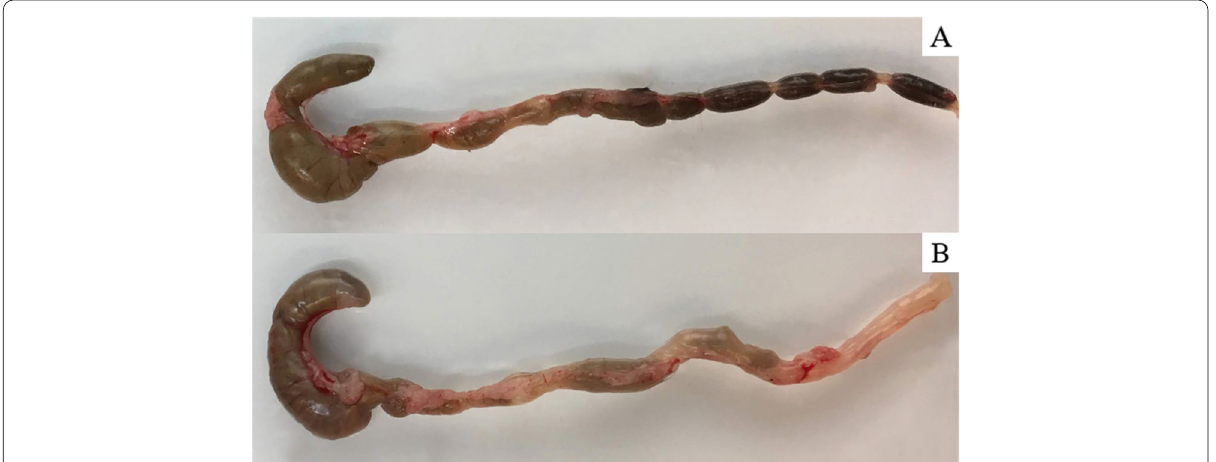
Fig. 2 Cecum and colon from ( A ) an uninfected mouse and ( B ) a mouse orally gavaged with Citrobacter rodentium , resulting in a thick and rigid distal colon partially devoid of content. The fecal material that remains in the colon of this mouse ( B ) is not as well formed as that in the colon shown in ( A